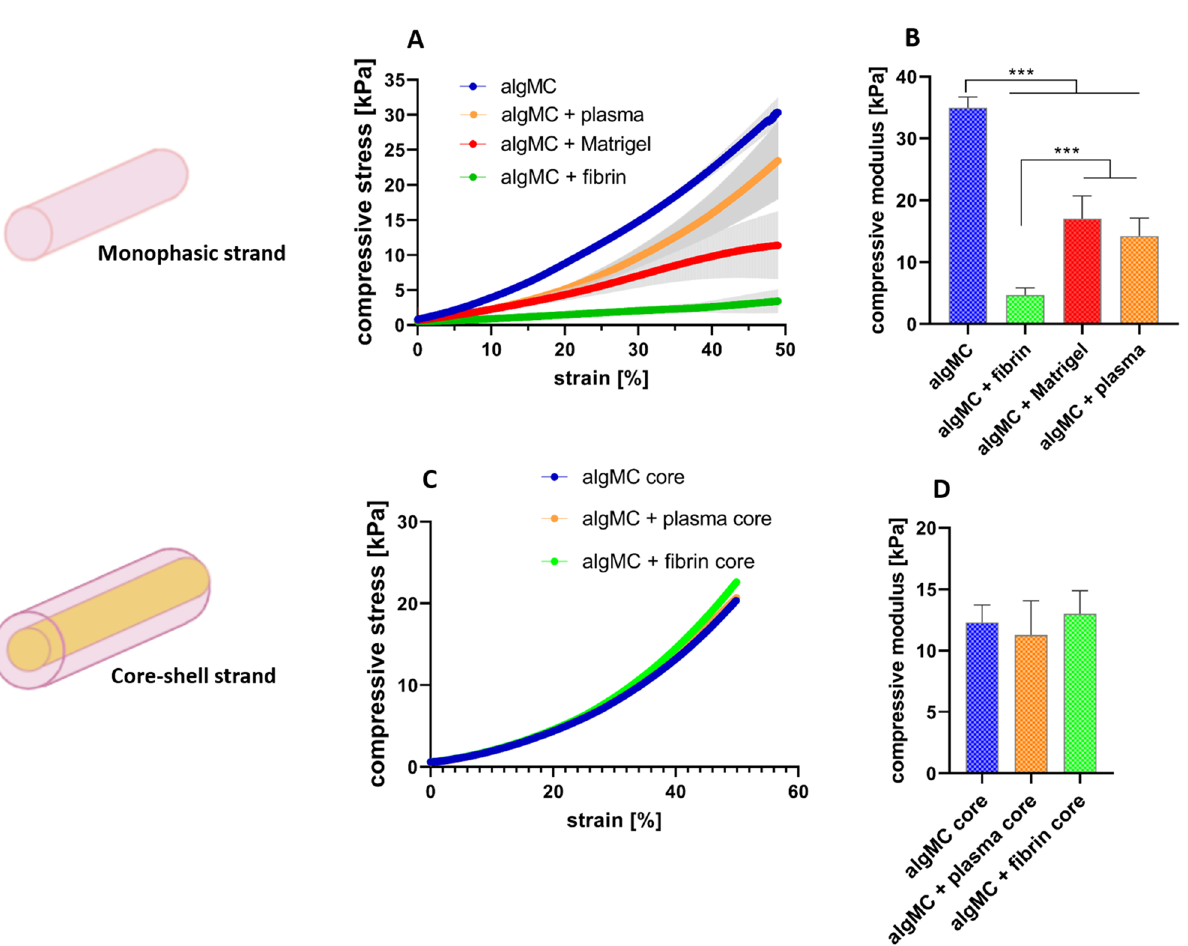
Figure 15. Mechanical characterization of monophasic and core–shell strand scaffolds after printing and crosslinking. ( A ) Stress–strain curves of cross-linked monophasic scaffolds at day1. ( B ) Compressive modulus of cross-linked monophasic scaffolds at day 1. ( C ) Stress–strain curves of cross-linked core–shell scaffolds with varying core compositions in algMC + Matrigel shell at day1. ( D ) Compressive modulus of cross-linked core– shell scaffolds at day 1 (n = 4, p *** < 0.0005, mean ±